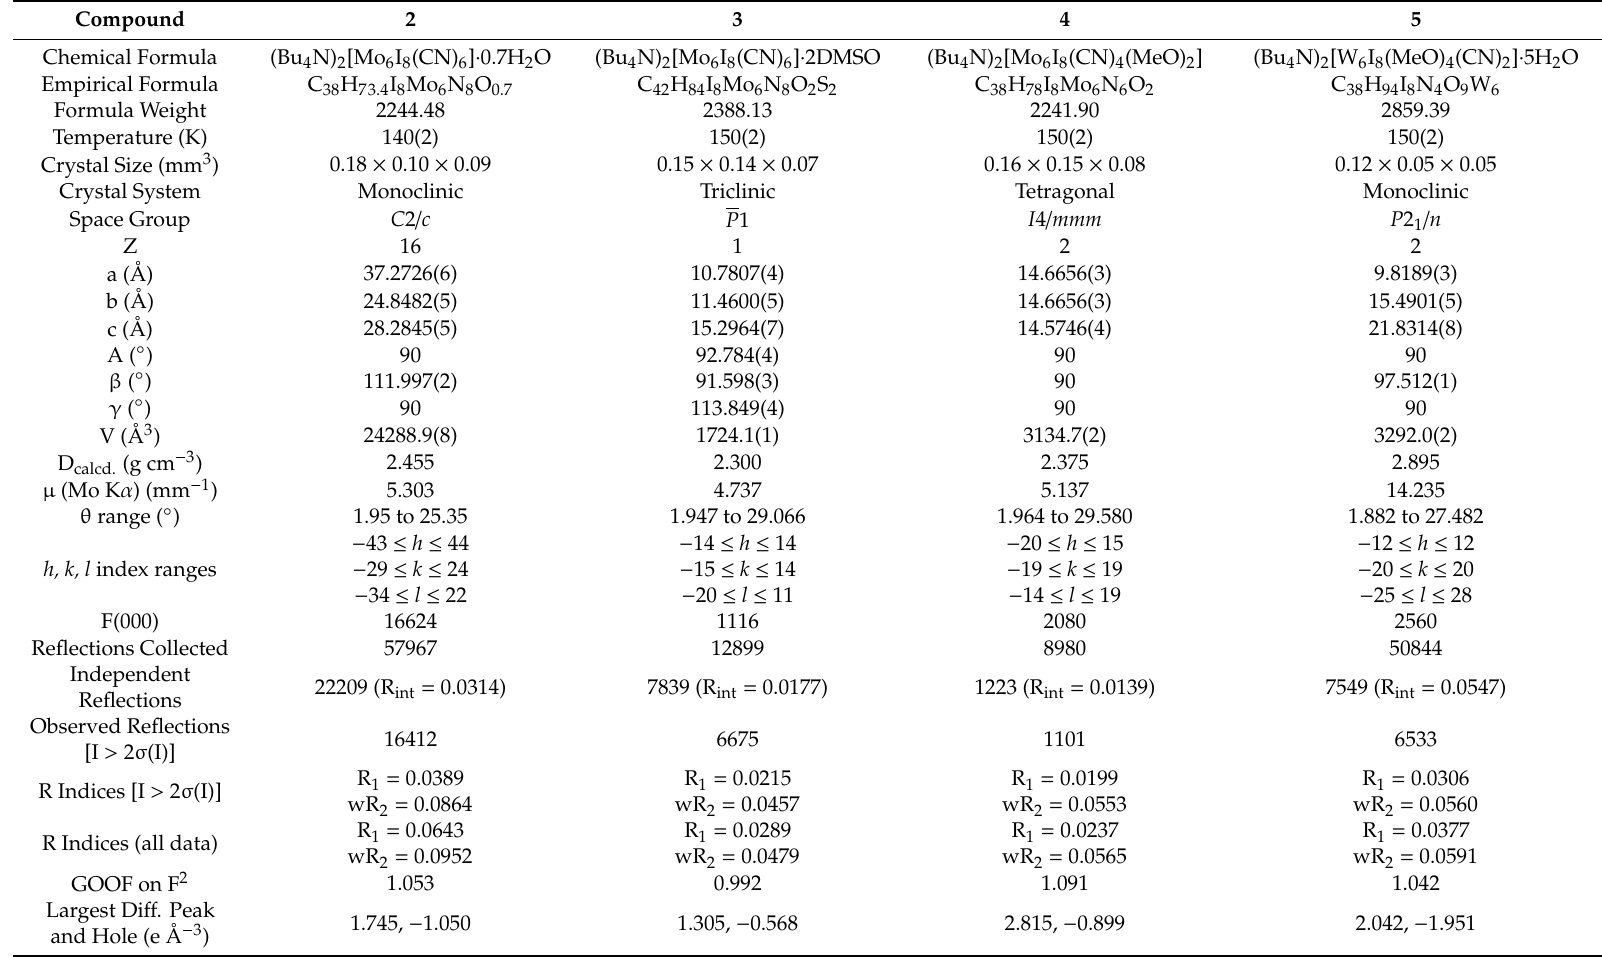
Table 4. Crystal data, data collection, and refinement parameters for 2 – 5